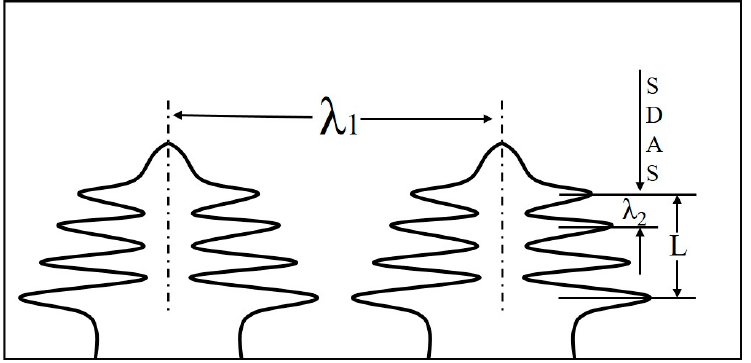
Figure 2. The schematic diagram for measuring the secondary dendrite arm spacing ( λ 2 ) by section method.